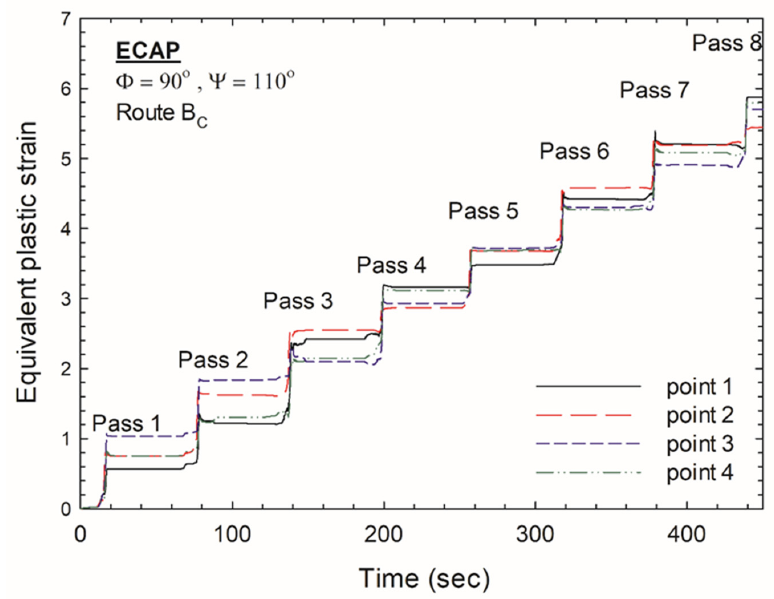
Figure 6. Equivalent plastic strain variation tracing through points 1, 2, 3 and 4 located in the cross-section of the mid-length of the billet during ECAP processing up to a total of 8 passes.